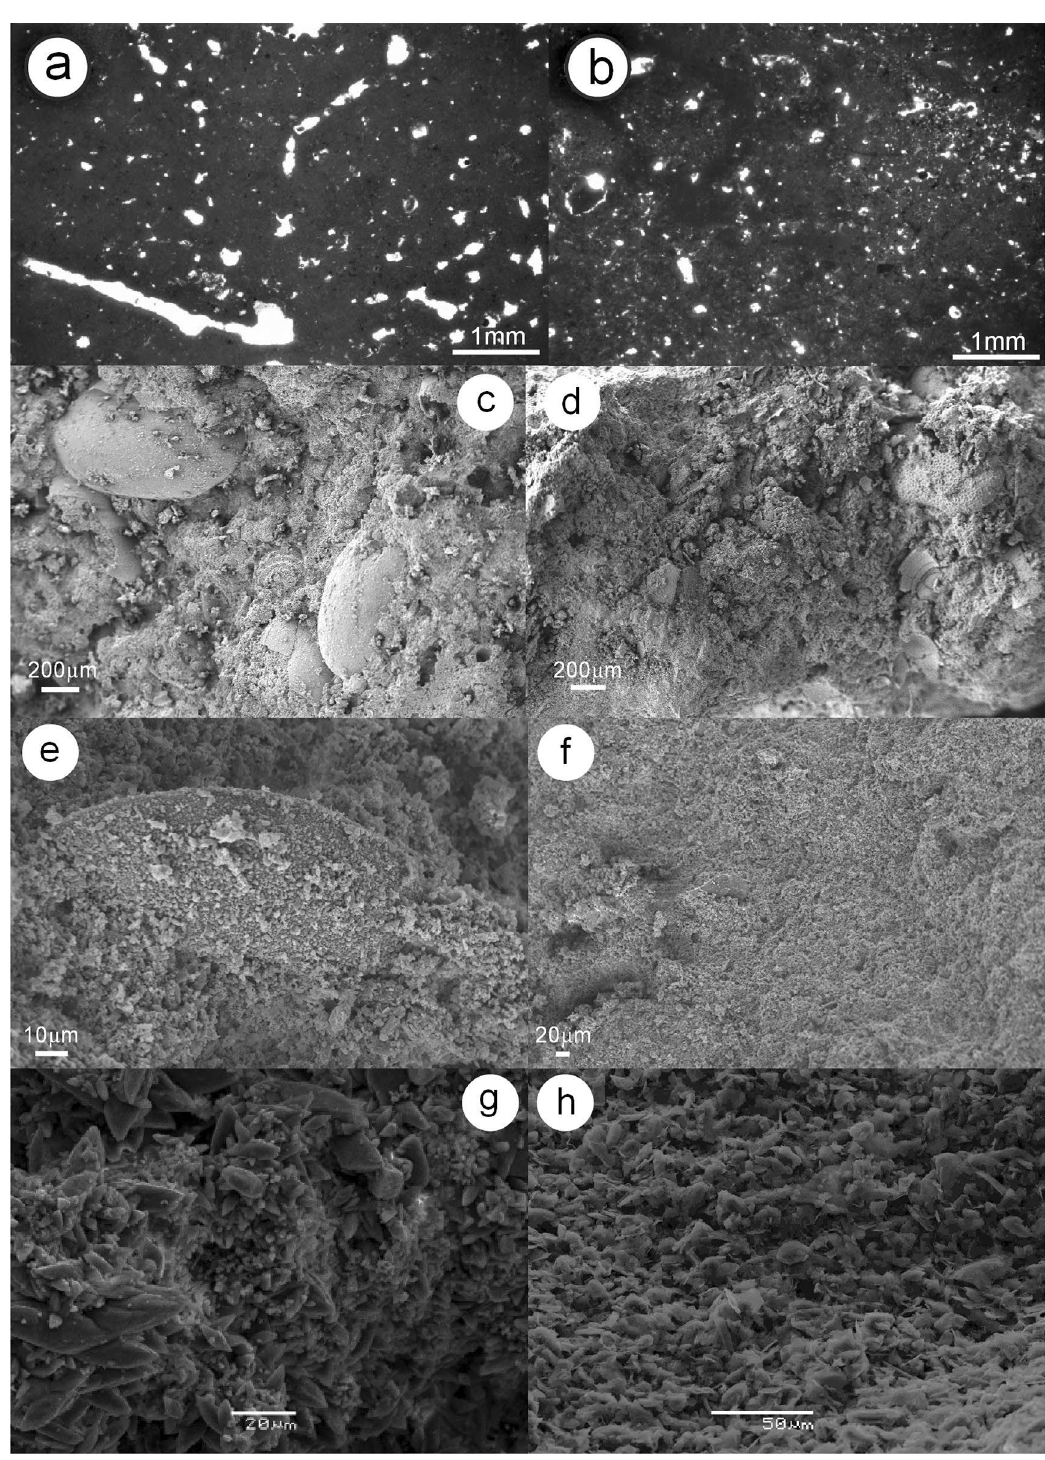
Figure 5. Petrography and SEM of the Venta Micena limestone. ( a ) Thin section of the lower subtly indurated level in the C1 interval in section VM4 (Fig. 3d,e). ( b ) Thin section of the subtly indurated level in Fig. 3b (C1 interval in section VM4). Both ( a , b ) show porosity likely to result from biogenic activity. ( c , d ) SEM images from section VM1, with abundant biogenic carbonates such as ostracods (intervals C1 and C2, respectively). ( e , f ) SEM images from section VM4 (interval C1), showing its general absence of invertebrates ( f ), except for rare microsparitized shells (an example of an ostracod test in e ). ( g , h ) SEM images from the stratigraphic height 0.9 m in section VM3 (interval C1), with well-crystallized calcite scalenohedra ( g ), and the limestone interval between indurated levels 1 and 2 in section VM3 ( h